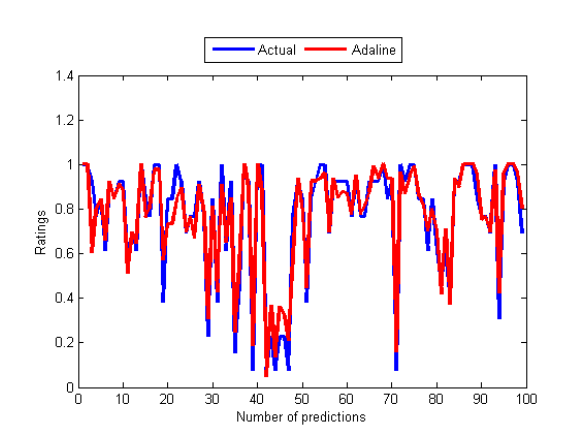
Figure 6. Curves of actual ratings and predicted ratings of Adaline.